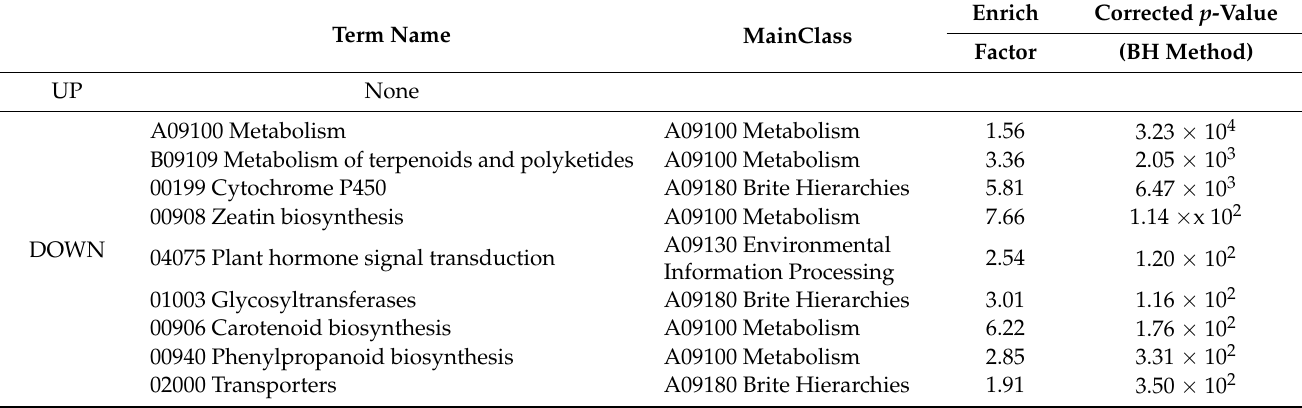
Table 2. Metabolic pathways and Brite Hierarchies enriched (UP) or under-represented (DOWMN) by the KEGG analysis in the freshly-harvested (FH) Pinalate fruit vs. the FH Navelate fruit. Three biological replicates from each condition were used. Only the DEGs ( p ≤ 0.05) that met a cutoff of |Log 2 FoldChange| ≥ 1 were considered in the analysis.